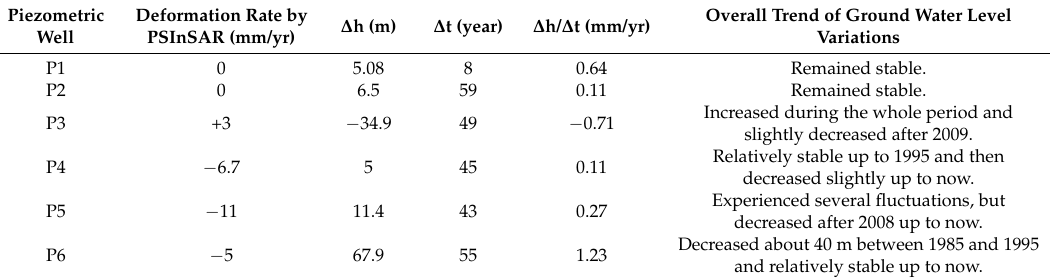
Figure 9. Temporal evaluation of groundwater level variations for six piezometers (P1 to P6) located in the study area of Sepulveda Transit Corridor. Table 3. Overall characteristics of the studied piezometric wells.